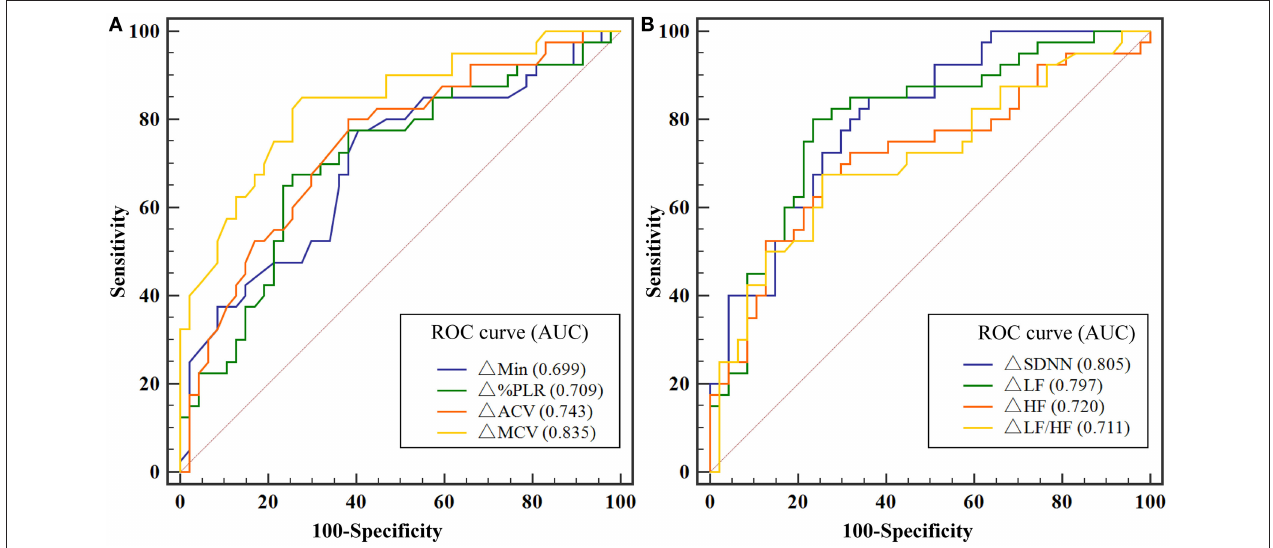
FIGURE 5 | (A) ROC analysis for the detection of driving fatigue with PLR variations. (B) ROC analysis for the detection of driving fatigue with HRV variations. Due to missing data of HRV of two participants, and missing data of PLR of one participant, the data of 29 participants were used for ROC analysis. ACV, average constriction velocity; AUC, area under the curve; Min, minimum pupil size; HF indicates high frequency; HFnu, normalization of HF power by the formula: HF / (LF + HF) * 100; HRV, heart rate variability; KSS, Karolinska Sleepiness Scale; LF, low frequency; LFnu, normalization of LF power by the formula: LF / (LF + HF) * 100; MCV, maximum constriction velocity; ROC, receiver operating characteristic curve; SDNN, standard deviation of the NN intervals; %PLR, constriction percentage; 1 , differences in all variables from baseline to the measurement at each